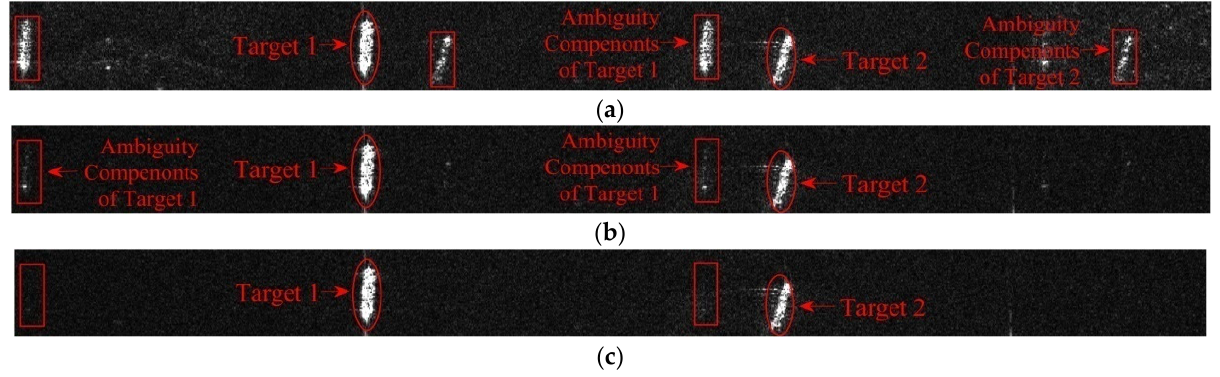
Figure 5. Enlarged target image results with different calibrations (horizontal azimuth, vertical range). ( a ) Result without calibration. ( b ) Result with subspace projection calibration. ( c ) Result with the proposed